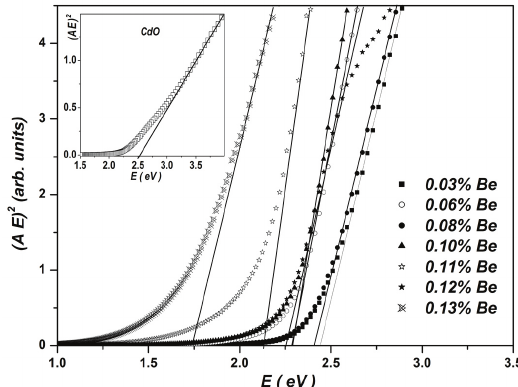
Figure 6. Tauc plots for Be-doped CdO films. The inset shows the Tauc plot for undoped CdO.